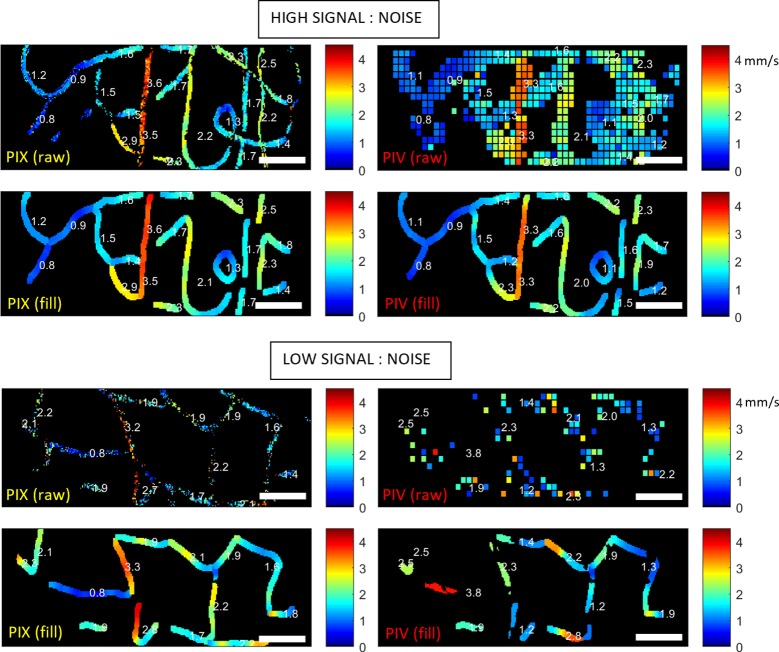
Example spatial maps of flow speed for both PIX and PIV.Panels correspond to the same sequences shown in Fig 1, and in S1 Video and S2 Video. Raw maps are shown at top in each panel, and interpolated maps are shown in the second row. Maps generated by the PIX algorithm are shown left, with comparison maps from PIV shown right. Scale bars show 50 μm.